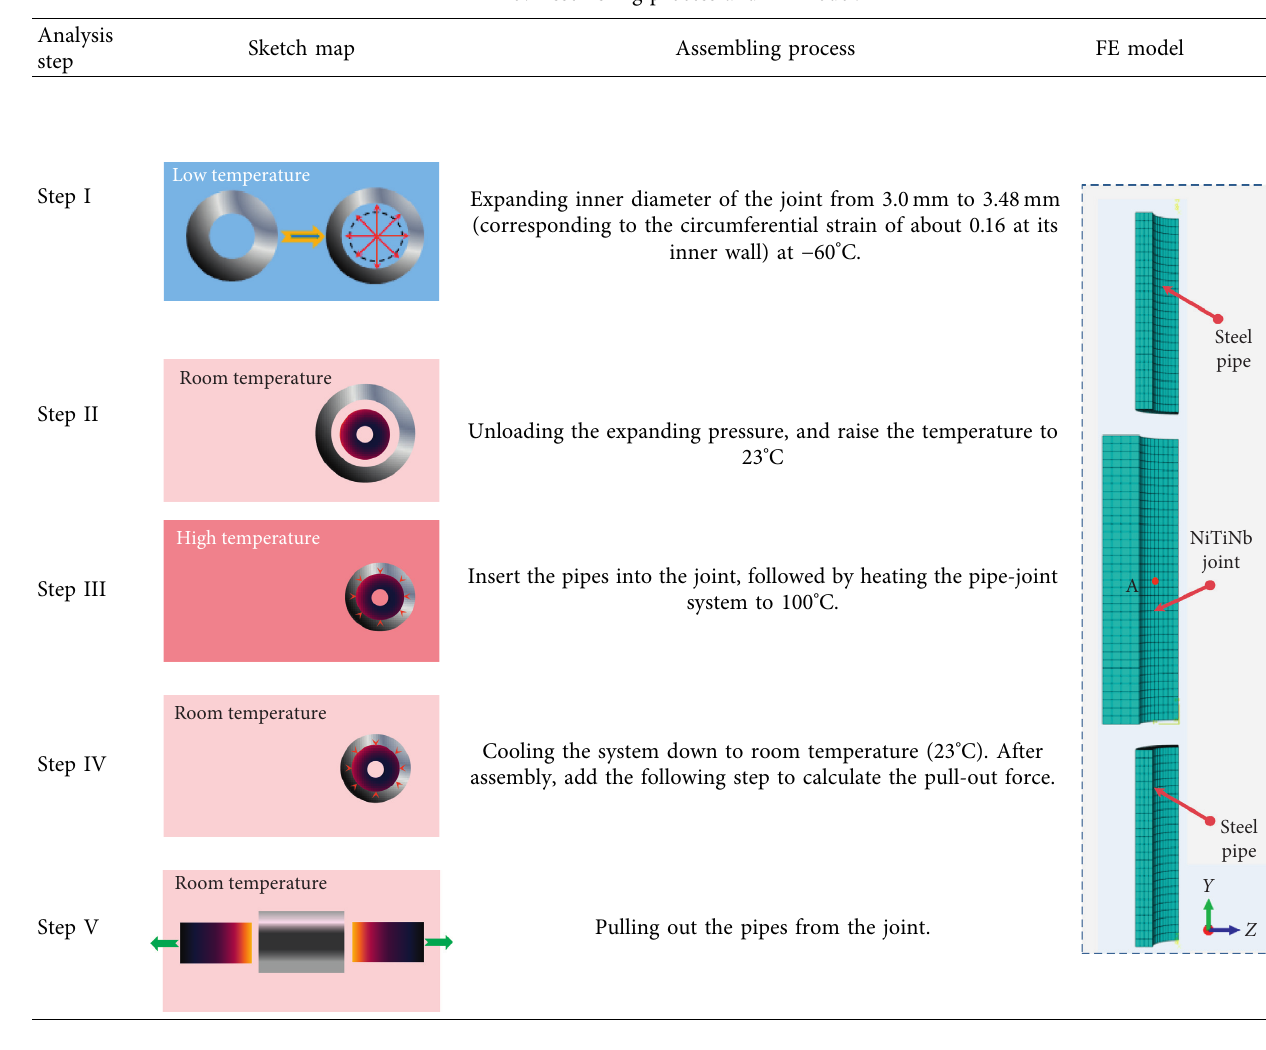
Table 3: Assembling process and FE